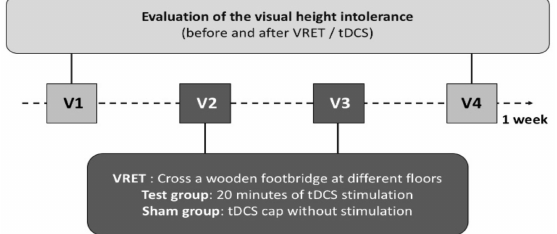
Figure 1. The study including two diagnostic sessions (V1 and V4) and two exposure sessions with tDCS or sham stimulation (V2 and